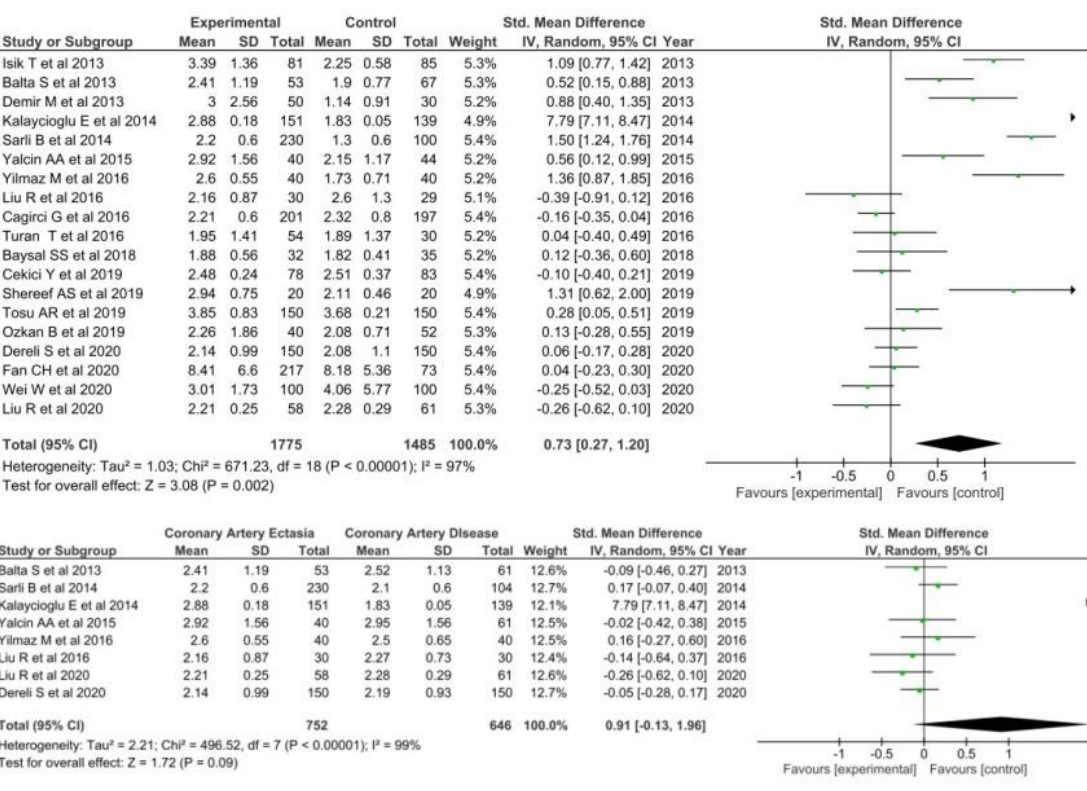
Figure 2. NLR in CAE patients versus controls (top) and CAE versus CAD patients (bottom).